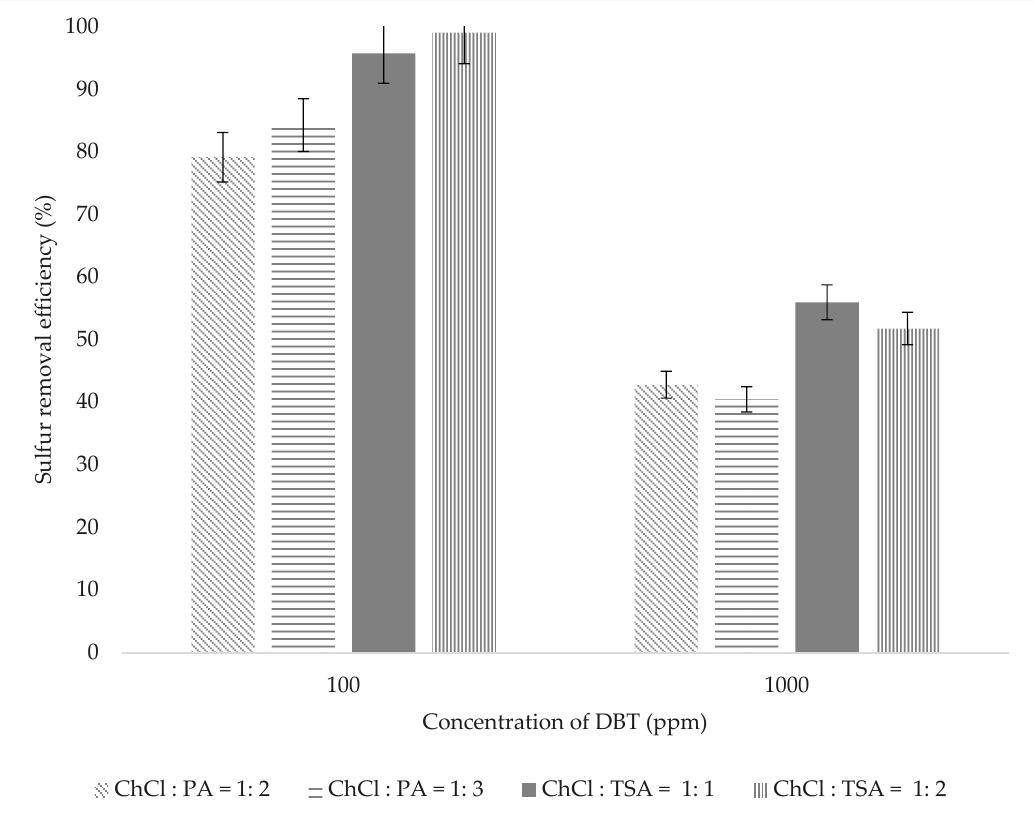
Figure 7. The effect of different concentrations of DBT in the model oil on the sulfur removal efficiency (0.01 g Cu-Fe/TiO 2 , H 2 O 2 as an oxidant with a ratio to DBT of 1:2, room temperature, EIL (ChCl:TSA = 1:2) to model oil ratio of 1:5, and 600 rpm stirring speed) .